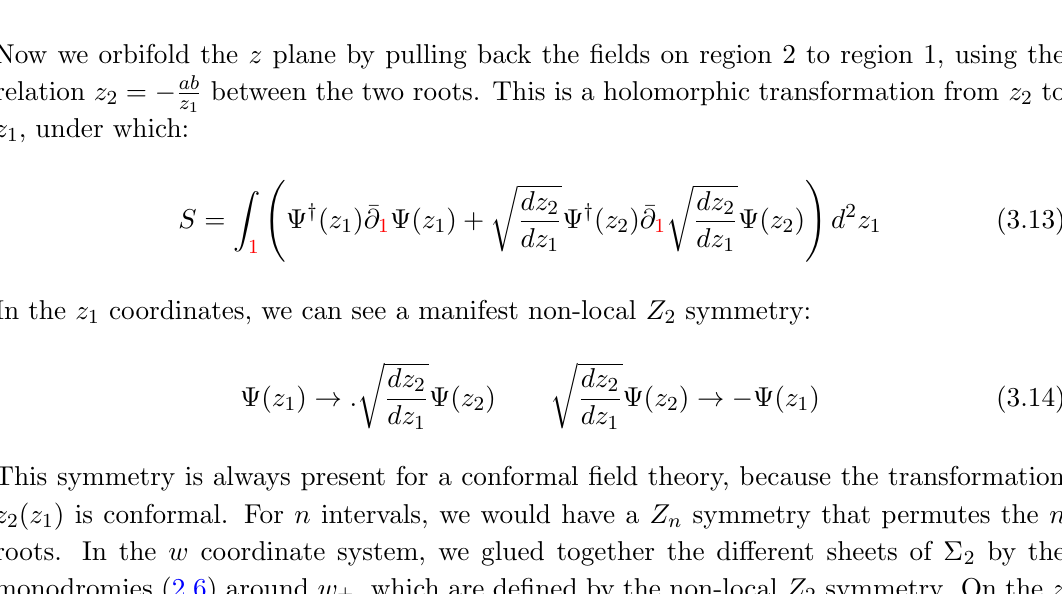
Figure 6 . The root functions. z 1 ; 2 ( w ) de(cid:12)ne two regions of the complex z plane minus the points z (cid:6) . A closed curve C + around w + on the w plane corresponds to an open curve on the z plane connecting z 1 to z 2